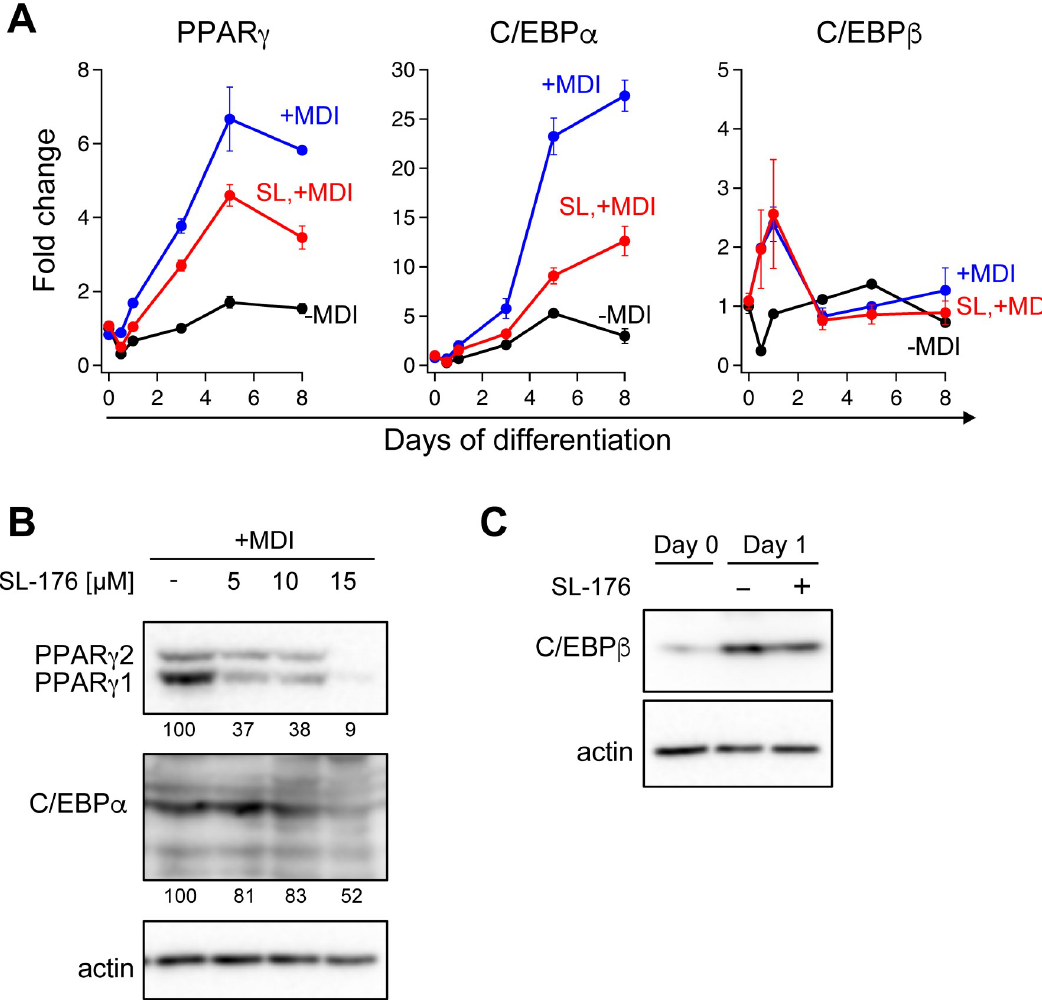
Fig 4. Expression of adipocyte markers were reduced by SL-176. (A) mRNA expression of the indicated genes was measured by RT-qPCR. Cells were treated with differentiation medium (MDI) with or without 10 μ M of SL-176. Black line, without MDI (control); blue line, with MDI; red line, 10 μ M of SL-176 with MDI. The data were normalized by actin and expressed as fold change. Values are the mean ± range of duplicates. Representative data from one of at least three independent experiments are shown. (B) Protein expression levels of PPAR γ 1/2 and C/EBP α in 3T3-L1 cells on Day 8 in the presence of 0, 5, 10, 15 μ M SL-176 were analyzed by Western blotting. The intensity of the protein was shown below the western panel as fold change compared with intensity of 0 μ M of SL-176. The values were normalized by of actin values. (C) C/EBP β protein expression in 3T3-L1 cells on Day1-differentiated in the presence of 10 μ M SL-176.